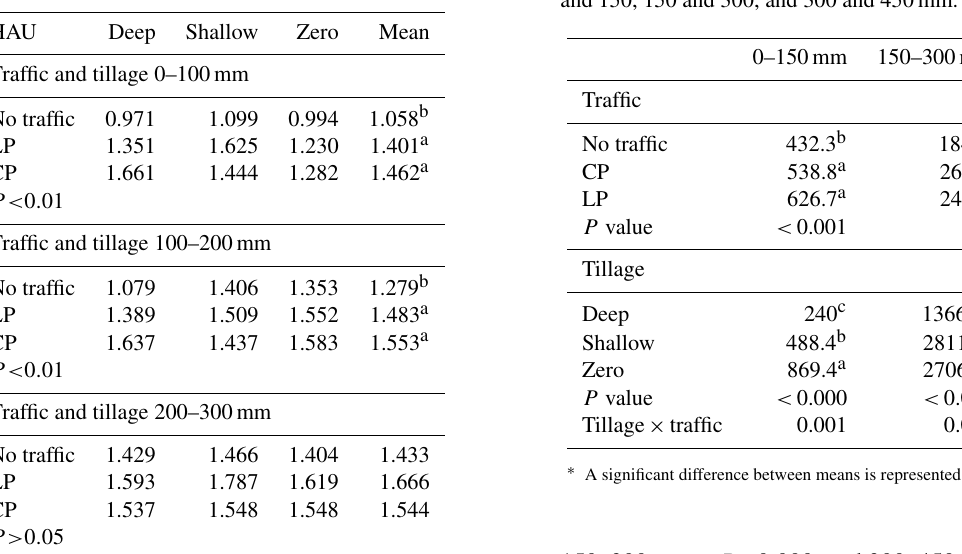
Table 2. Analysis of variance for bulk density × traffic, tillage, and tillage × traffic.